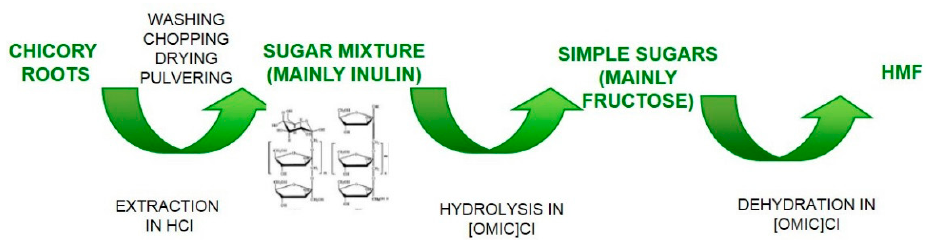
Figure 4. Scheme of the direct process from chicory roots to HMF [ Error! Bookmark not defined. ].